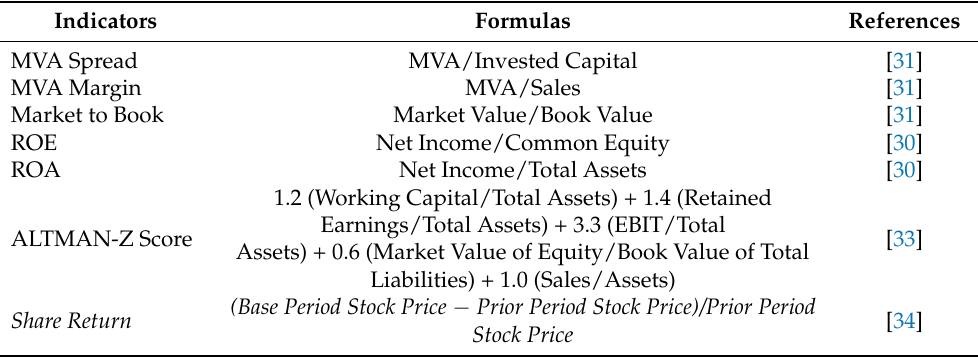
Table 2. Financial Criteria, Calculation and